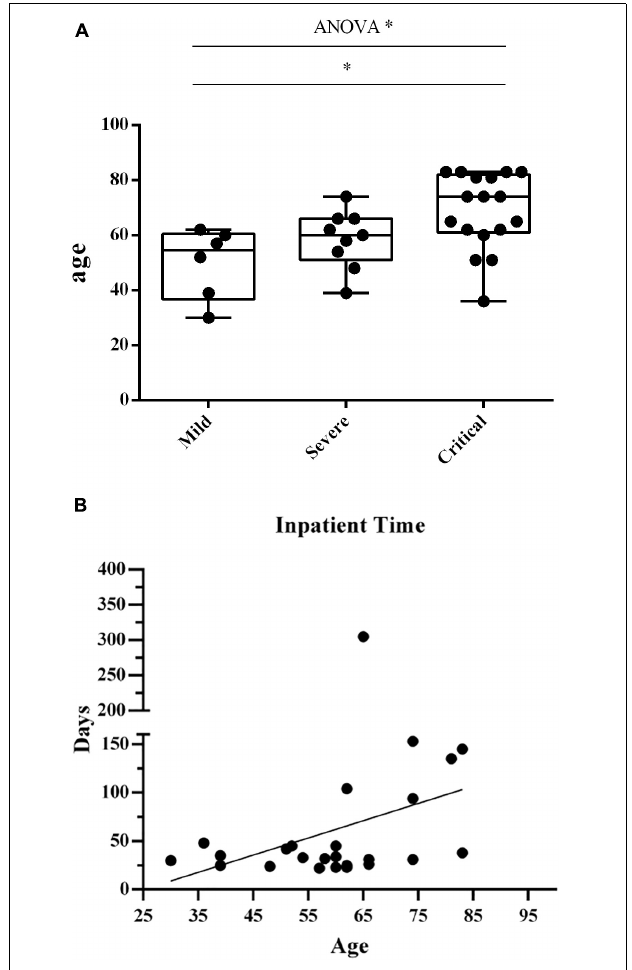
FIGURE 1 | (A) The age in the 3 groups of patients. The age distribution in three groups of patients. Each dots indicate a single individual patient. ∗ p < 0.05. (B) Correlation between patients’ age and hospitalization time. Correlation analysis between patients’ age and hospitalization time length. Each dots indicate a single individual patient. The X -axis shows the age of patients, and the Y -axis indicates the duration of hospitalization from the first visit to discharge.